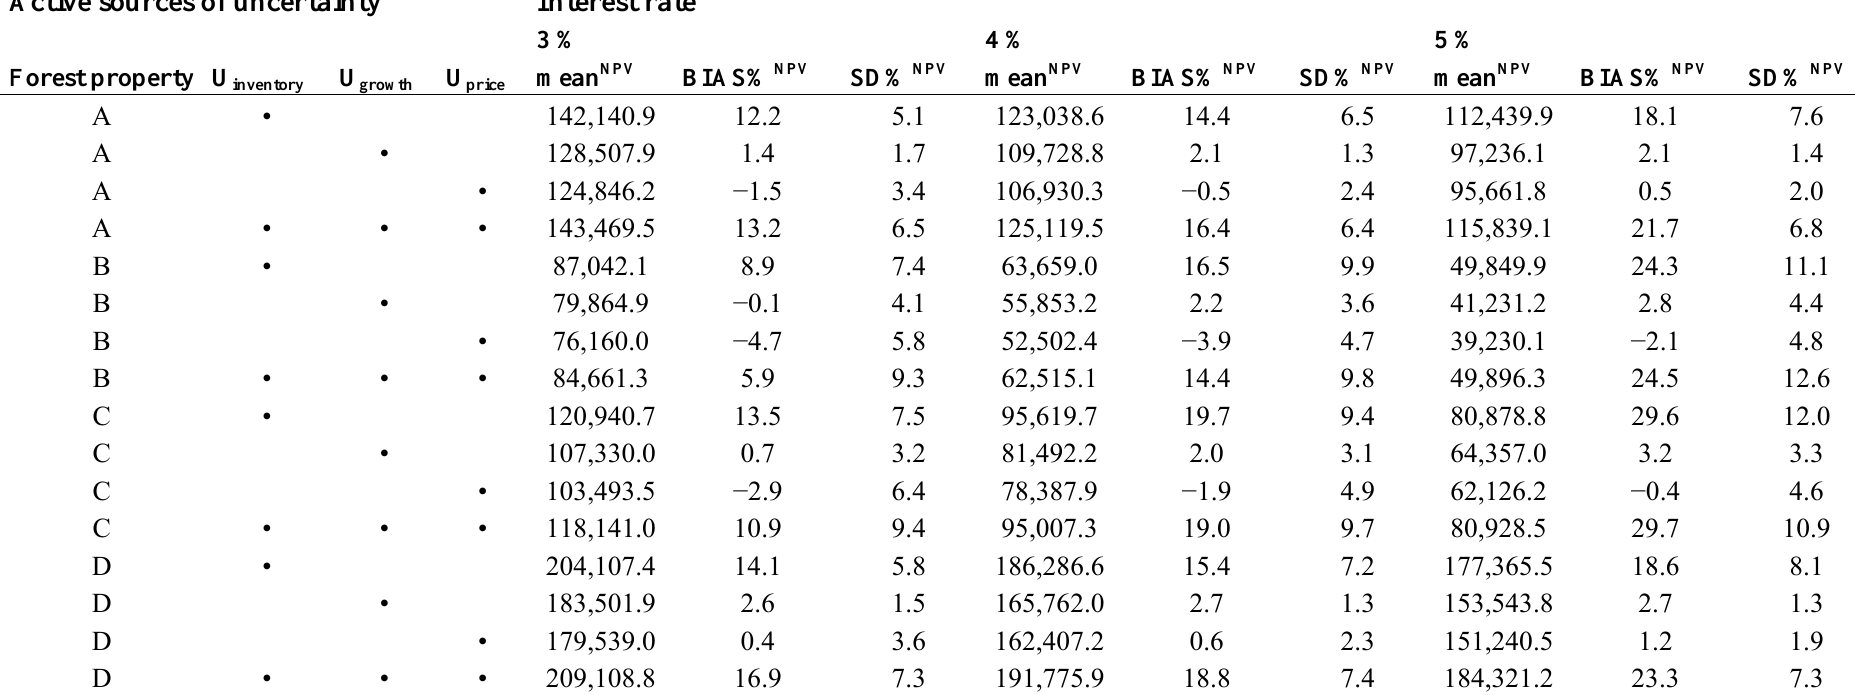
Table 1. Averages of the relative biases (BIAS% NPV ) and standard deviations (SD% NPV ) of the simulated NPV distributions of the 25 hectare forest property with given source of uncertainty and interest rate